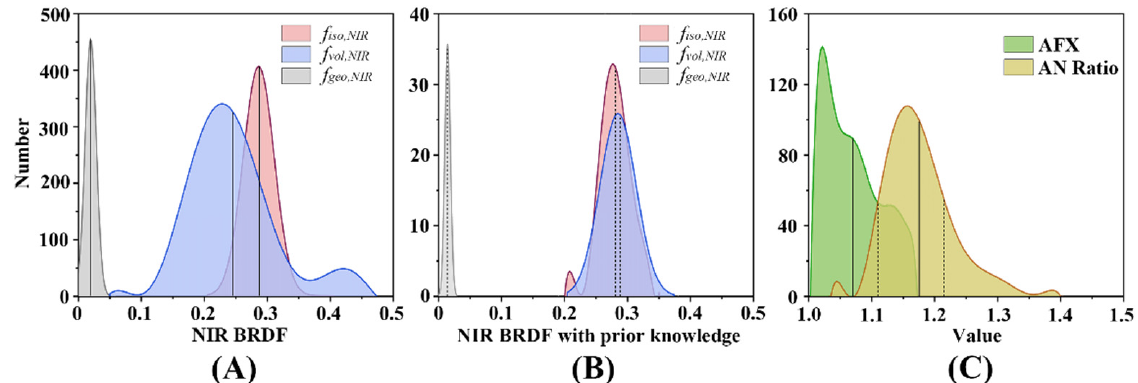
Figure 4. Histograms of the pure pixels BRDF parameter values of Class 1 in the Landsat scene of Northwestern Mississippi on April 09, 2014. The solid lines represent the value corresponding to the concurrent approach, and the dashed lines represent the value corresponding to the new algorithm. ( A ): the pure pixel BRDF parameters without prior knowledge; ( B ): the pure pixel BRDF parameters with prior knowledge; ( C ): AFX (the Anisotropic Flat Index) and AN ratio (Albedo-to- Nadir reflectance ratio). Table 4. AFX (the Anisotropic Flat Index) and six BRDF Archetypal ranges in NIR Band offered by Jiao et al. [49].